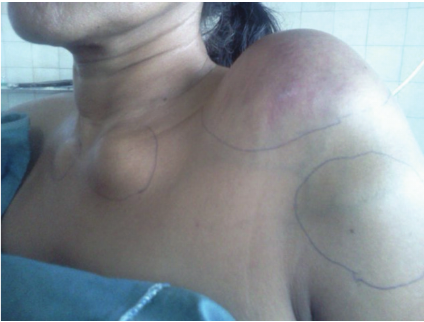
Figure 3: Patient with swelling over left shoulder, bilateral stern- oclavicular joints, and left upper arm (before